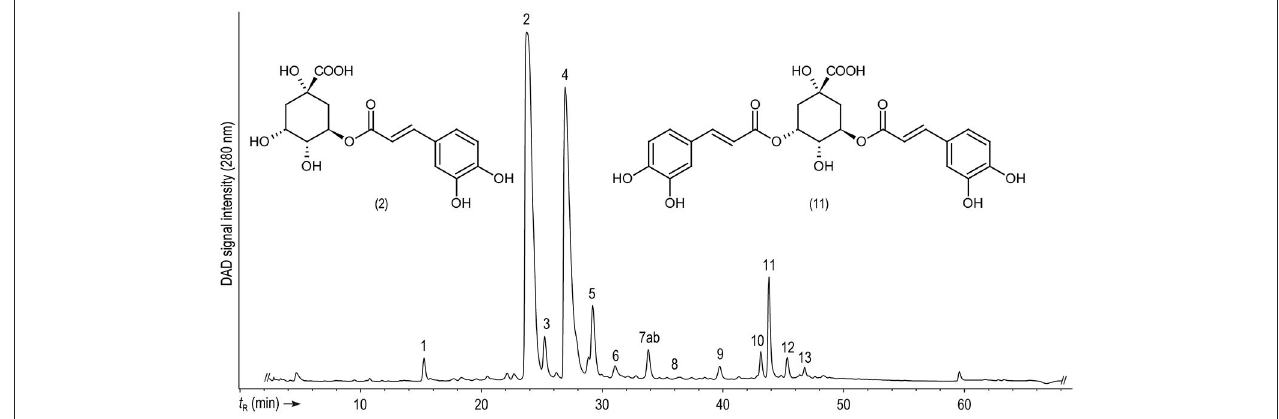
FIGURE 1 | Representative HPLC-DAD chromatogram showing the separation of non-anthocyanin phenolic compounds present in the peels of Caturra amarillo (yellow variety) monitored at 280nm. For peak assignment, see Table 1